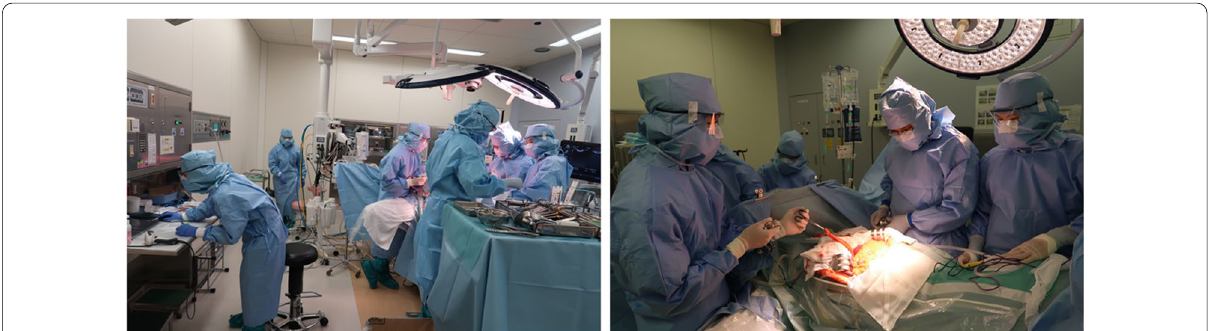
Fig. 3 View of the operating room. The operation was performed in a negative pressure room. All medical staff wore personal protective equipment, including N95 respirators